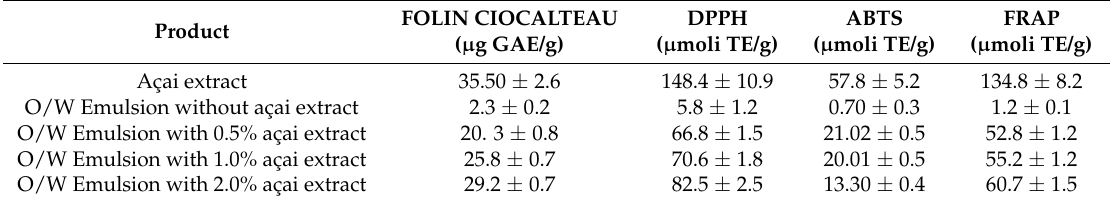
Table 3. Results of total phenol content and antioxidant activity for açai extract and formulations containing different percentages of açai extract.